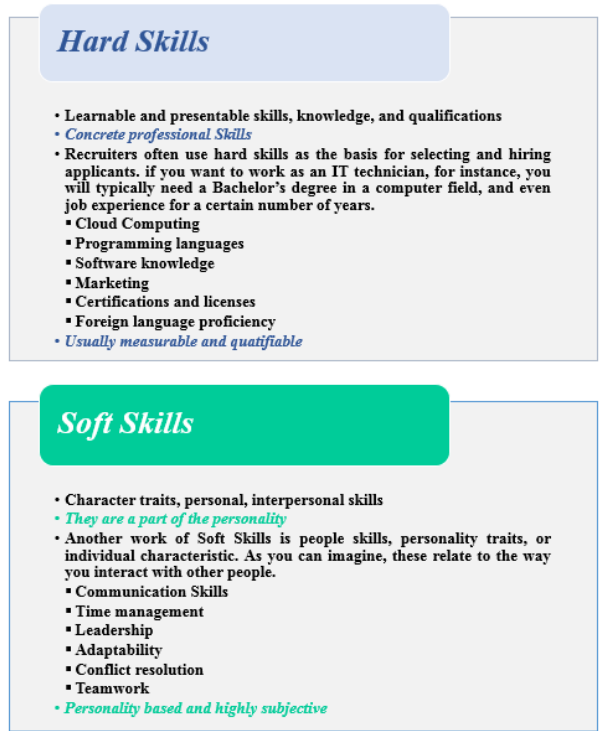
Fig. 3. The difference between Hard skills and soft